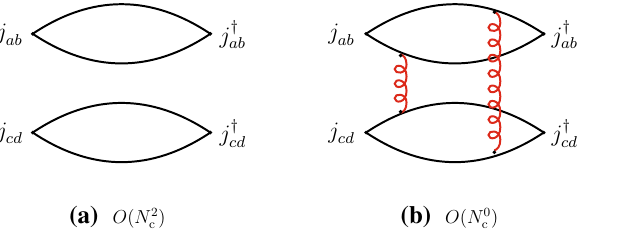
Fig. 1 Leading-andsubleading-orderdiagramsofthe“direct”channel IofEq.(2.3). a Disconnectedpart; b connectedpart(asamplediagram). Full lines represent quarks, curly lines gluons. Similar diagrams exist for the “direct” channel II